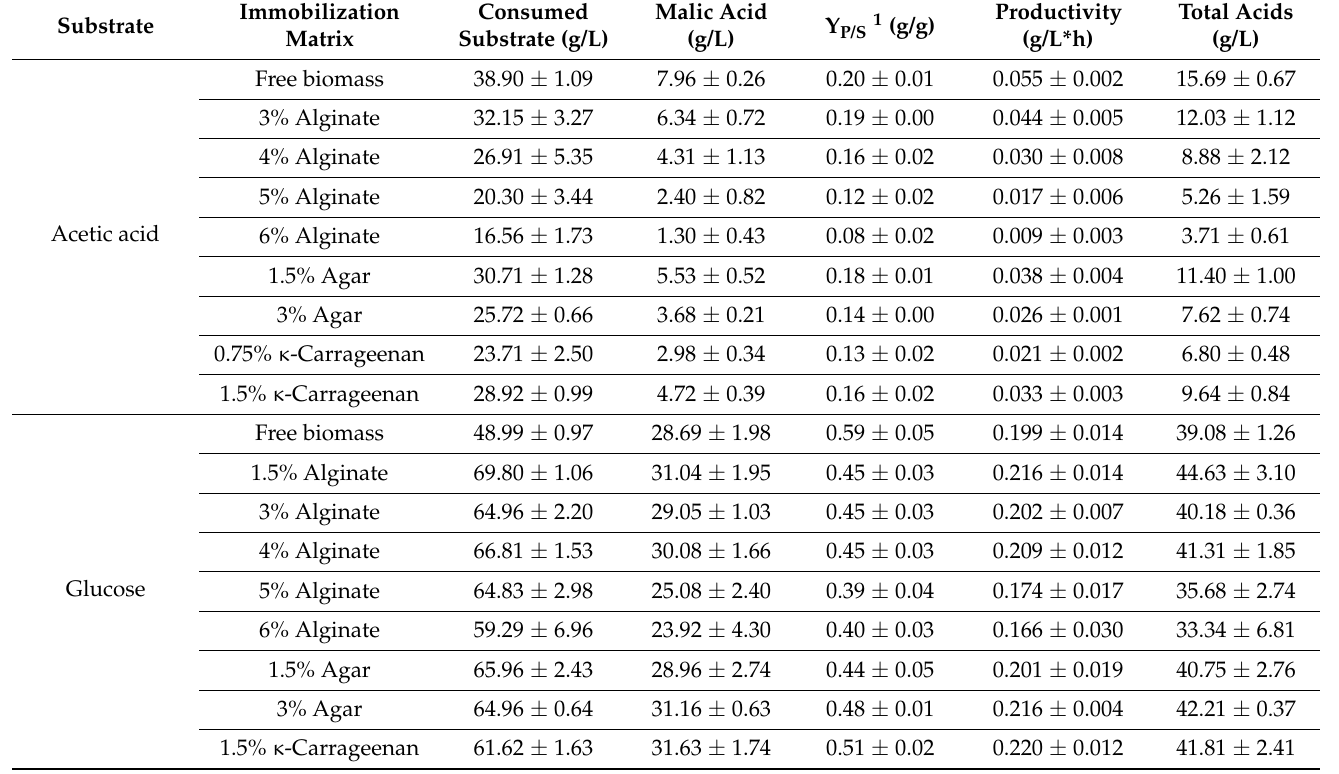
Table 1. Fermentation results for shake flask cultivations of A. oryzae after 144 h. Values are means of triplicates with standard